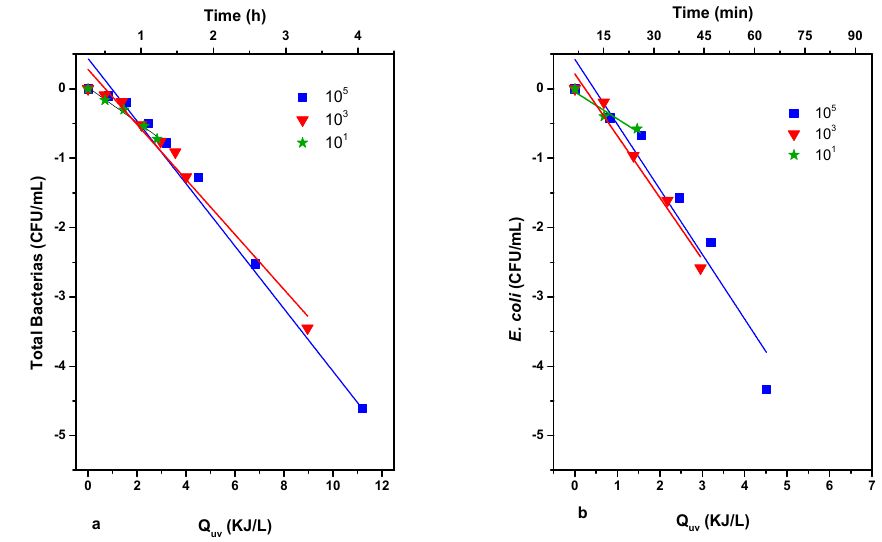
Figure 9. TiO 2 -LDPE pellets (52 mg/L) efficiency in the inactivation of different initial concentration of ( a ) total bacteria, ( b ) E. coli . Table 4. Kinetic data of Total bacteria and E. coli photocatalytic experiments with TiO 2 -LDPE pellets.